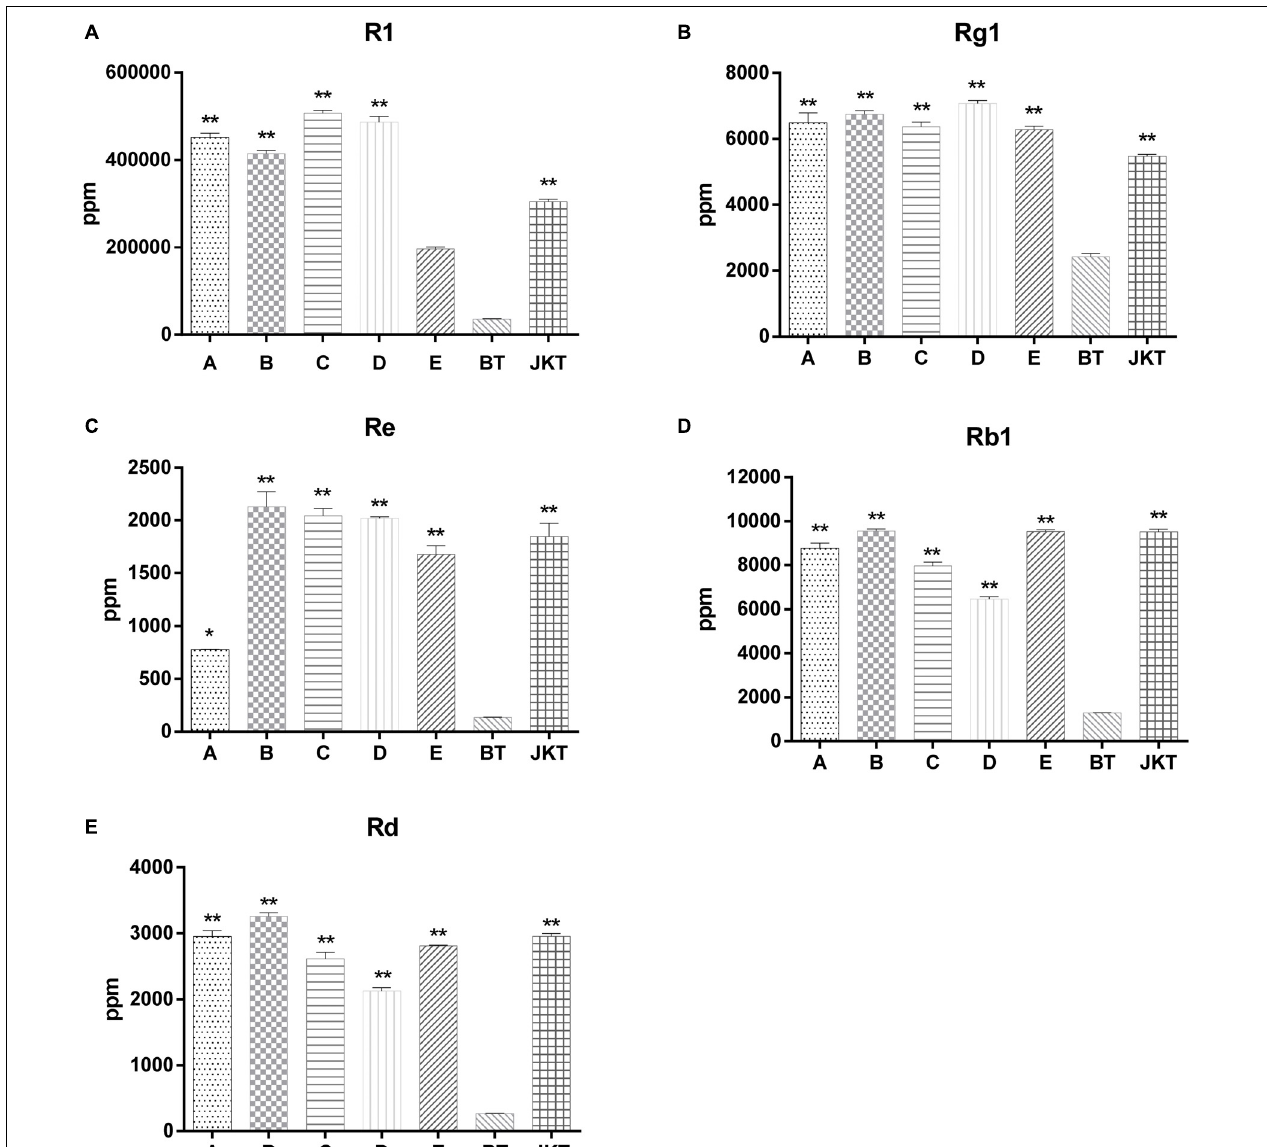
FIGURE 1 | The significant difference between five major saponins (R1, Rg1, Re, Rb1, and Rd) in P. notoginseng compared to severe diseased plants (BT). A , B , C , and D represents four probiotic consortia; E represents biopesticide, JKT; and BT represents healthy plants and diseased plants without any treatment. LSD test was used and at a p -value < 0.05 marked as * and a p -value < 0.01 marked as